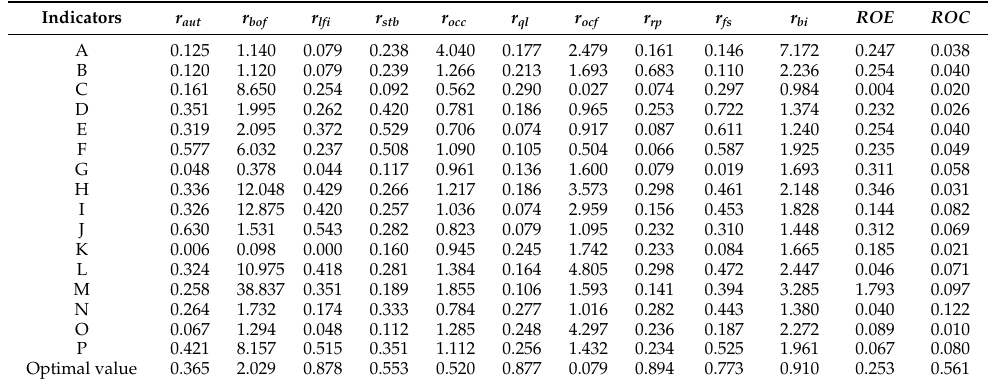
Table 3. Adjusted indicators of financial support for the textile enterprises development in 2019.